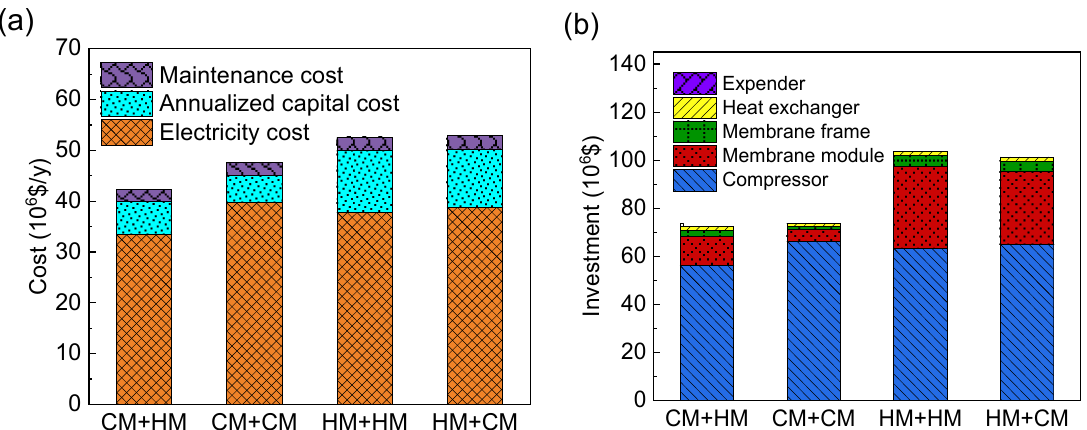
Figure 14. ( a ) investment and ( b ) comparison of the optimal process of different membrane type combination under the condition of 96% CO 2 purity and 90% CO 2 recovery.